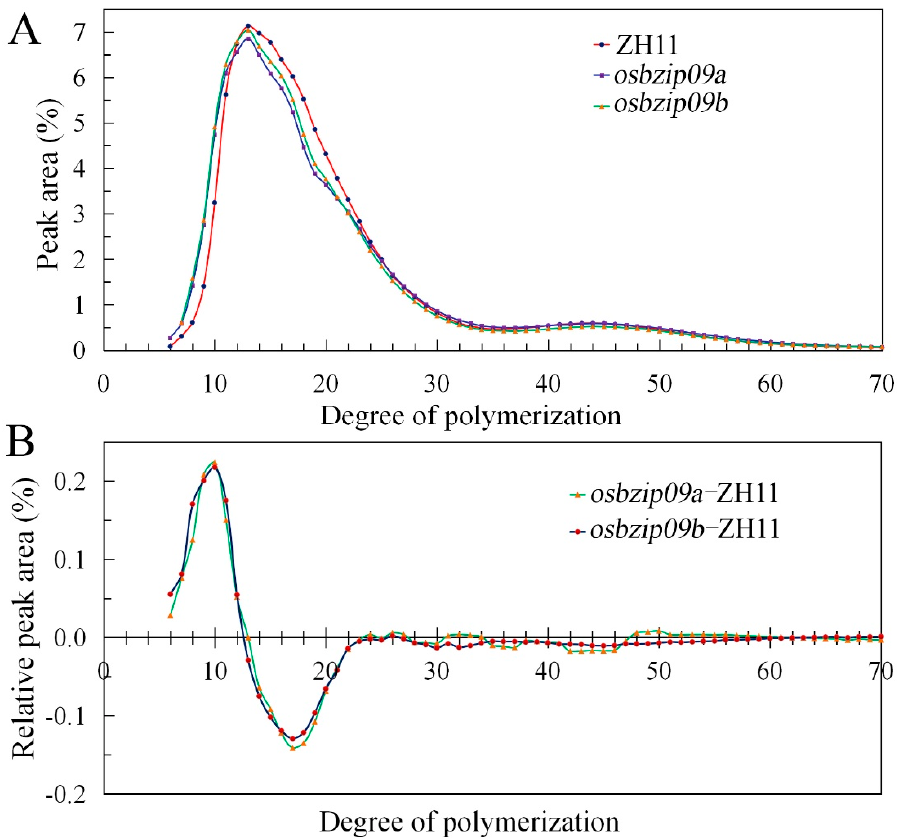
Figure 3. Chain-length distribution of starch from different rice lines. ( A ) indicates the distribution of polyglucans from the endosperm of ZH11 and its mutant lines osbzip09a and osbzip09b ; ( B ) represents the differences in the chain-length distributions between wild-type ZH11 and the mutant lines osbzip09a and osbzip09b .